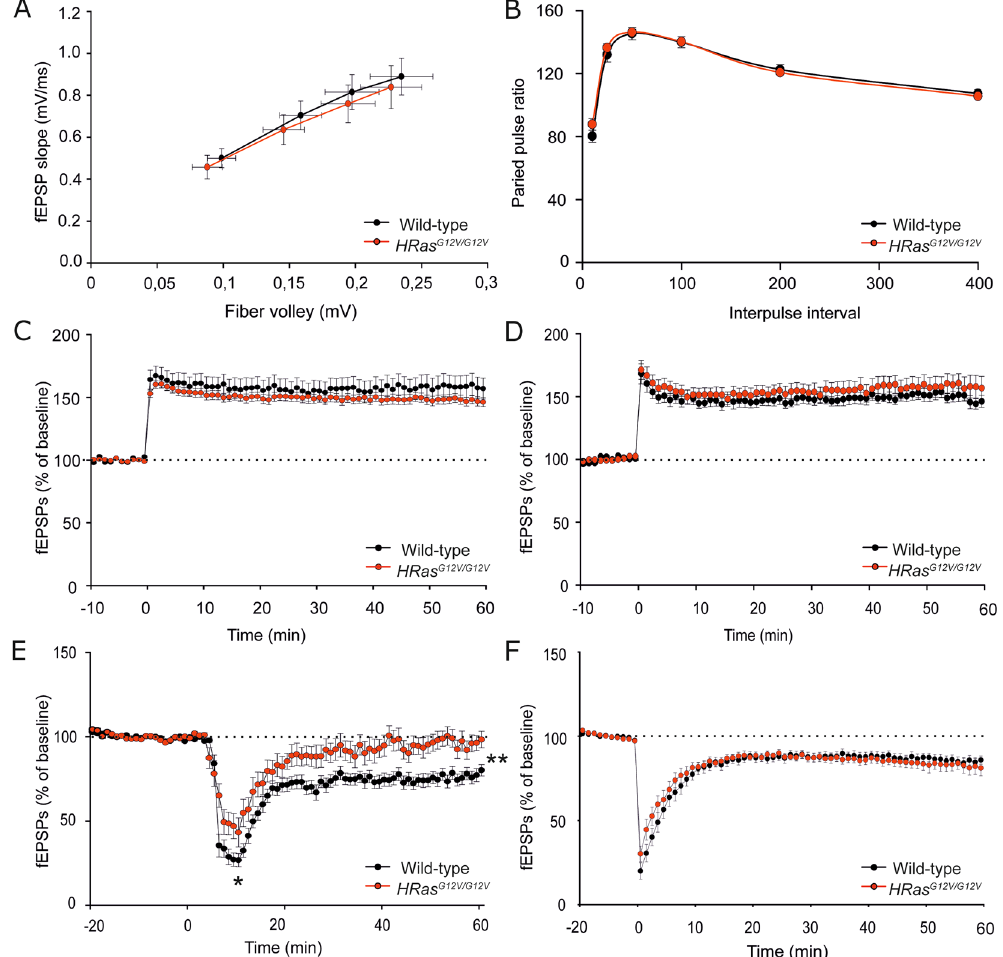
Figure 5. Normal long-term potentiation (LTP) but impaired mGluR-dependent long-term depression (LTD) in HRas G12V/G12V mice. ( A ) Field recordings of acute hippocampal slices revealed normal basal synaptic transmission in HRas G12V/G12V mice (effect of genotype: fiber volley: F 1,53 = 0.15, P = 0.70, fEPSP slope: F 1,53 = 0.17, p = 0.68). Data are presented as mean ± SEM from wild-type n = 29 slices/4 mice and HRas G12V/ G12V n = 26 slices/4 mice. ( B ) Paired-pulse ratio is not altered in HRas G12V/G12V mice compared to WT controls ( F 1,14 = 0.36, P = 0.56). Data are presented as mean ± SEM from: for 2.5 mM KCl: HRas WT/WT n = 25 slices/6 mice, HRas G12V/G12V n = 26 slices/8 mice. (C-D) Normal LTP at Schaffer collateral-CA1 synapses in HRas G12V/ G12V induced by ( C ) theta burst stimulation (TBS, effect of genotype: F = 0.92, P = 0.51) or by ( D ) 100 Hz 1,20 stimulation. Data are presented as mean ± SEM from for ( C ) wild-type n = 9 slices/4 mice, HRas G12V/G12V n = 13 slices/4 mice n = 29 slices/4mice and for ( D ) wild-type n = 9 slices/4 mice, HRas G12V/G12V n = 7 slices/4 mice. ( E ) DHPG application (50 μ M, 5 min) induced stable long-term depression (LTD) in WT mice. Impaired LTD was observed in HRas G12V/G12V mice ( F 1,34 = 13.29, P < 0.01). Data are presented as mean ± SEM from wild-type n = 20 slices/3 mice, HRas G12V/G12V n = 16 slices/3 mice. ( F ) NMDA receptor-dependent LTD, induced by low frequency stimulation (LFS), was indistinguishable between wild-type and HRas G12V/G12V mice ( F 1,26 = 0.40, P = 0.53). Data are presented as mean ± SEM from wild-type n = 17 slices/4 mice, HRas G12V/G12V n = 11 slices/3 mice. Statistical test for ( A–F) : one-way repeated measures ANOVA. Data are expressed as percentage of the baseline prior to the stimulation